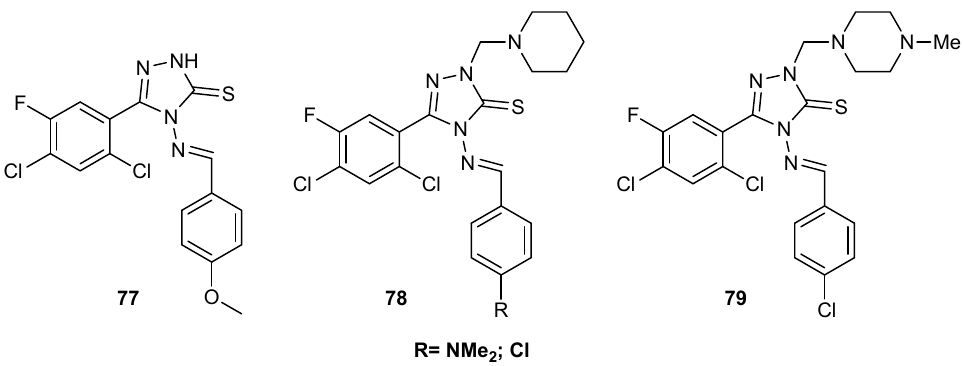
Figure 7. Chemical structure of 2,4-dichloro-5- fl uorophenyl Schiff